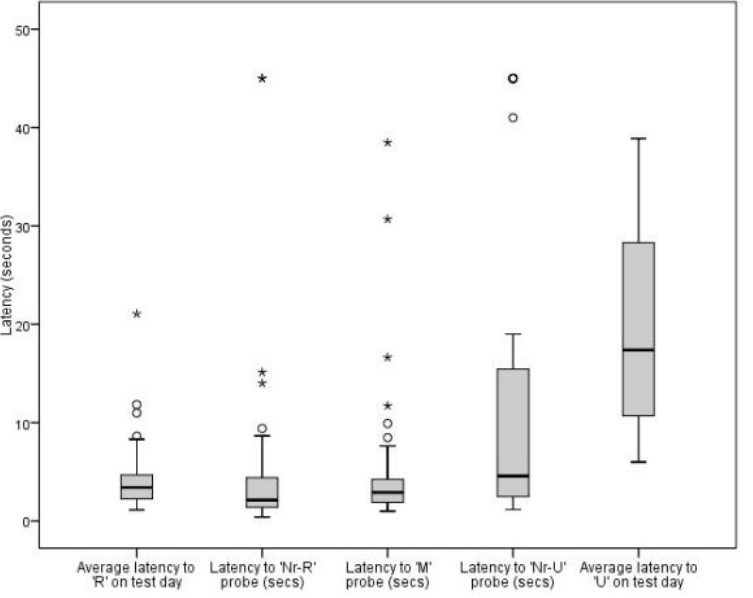
Figure 3. Box plot showing latencies to bowl locations during judgment bias testing for 42 cats with useable data. Outliers (  ) and extreme outliers (*) are